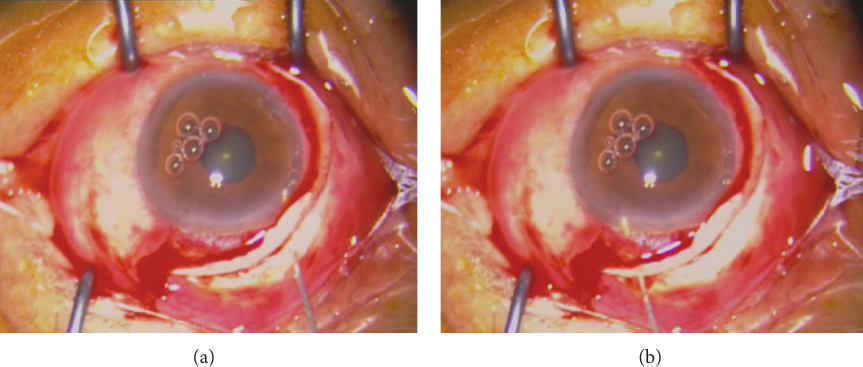
Figure 2: Probe detection of a cleft (case 5). A blunt needle with a syringe was gently inserted into the anterior chamber through a deep scleral incision from the middle (a) to the end of the cleft (b), stopping whenever it was unable to move. This stop site was the anatomical site of the ciliary muscle’s attachment to the scleral spur, as well as the exact end of the cleft.